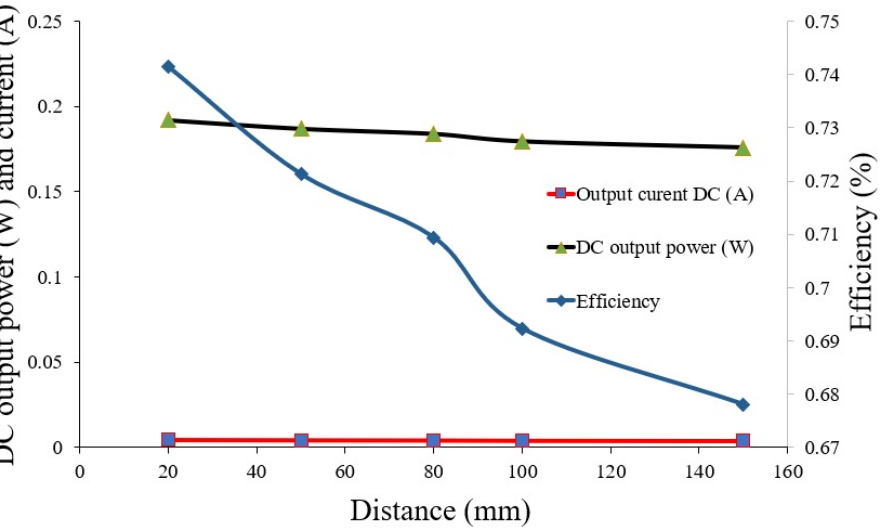
Figure 18. Experimental measurement results of WPT between STLAC and MTSCC in lateral misalignment with DC output power (measured in W), transfer efficiency (%) and output current (measured in